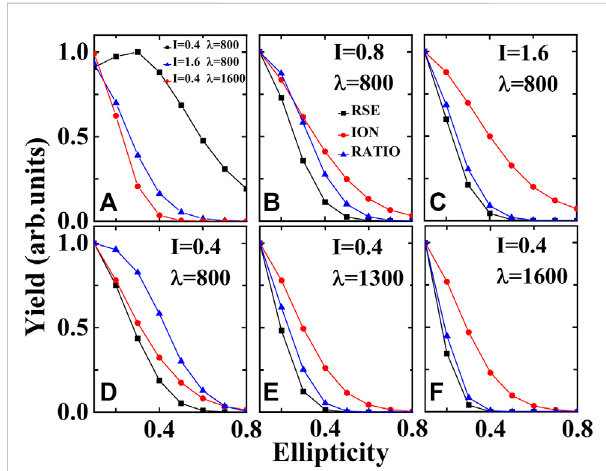
FIGURE 1 (A) The calculated ratio between the yields of RSE and ionization processes as a function of the ellipticity by the adiabatic semiclassical model.The laserintensities areindicatedintheunitof10 14 W / cm 2 .The laserwavelengthesare800 nm(blacksquares andbluetriangles) and 1,600 nm (red circles). (B – F) The calculations by the nonadiabatic semiclassical model. The calculated normalized yields of RSE (black squares), ionization (red circles) and the ratio between them (blue triangles) as a function of the ellipticity at the intensities of (D) 0.4, (B) 0.8 and (C) 1.6 (in the unit of 10 14 W / cm 2 ) at 800 nm. The ellipticity dependence of the corresponding normalized yields at the wavelengthes of 800 nm (D) , 1300 nm (E) , 1600 nm (F) at 0.4×10 14 W / cm 2 have also been